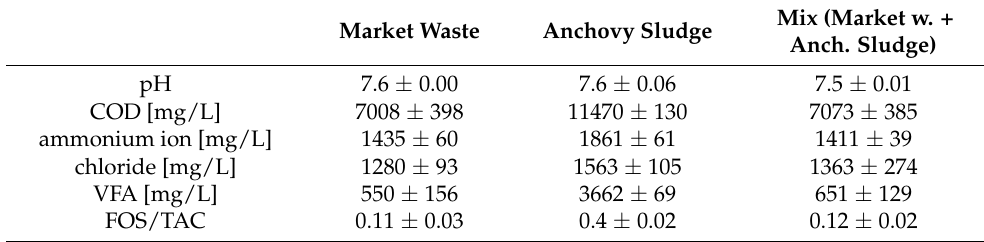
Table 4. Analyses of digestate from BMP